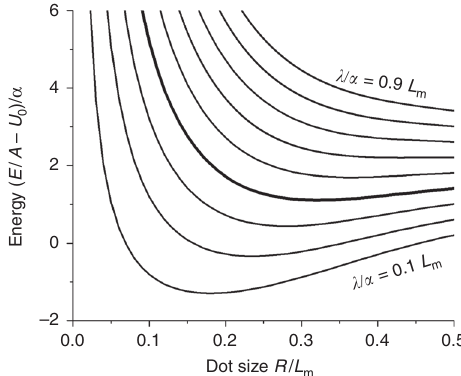
Fig. 6 Energy vs. dot size, in units of α , from Eqs. (1 and 2). The energy is calculated per unit area of graphene, while the dot size is in units of moiré periodicity ( L m ) . Curves correspond to different values of λ / α , ranging from 0.1 L m ( bottom ) to 0.9 L m ( top ). The heavier curve ( λ / α = 0.4 L m , fourth from bottom ) gives a dot radius close to the experimentally observed size. For values of λ / α greater than around 0.6 L m ( sixth curve from bottom), there is no minimum at any R , suggesting that dots will not